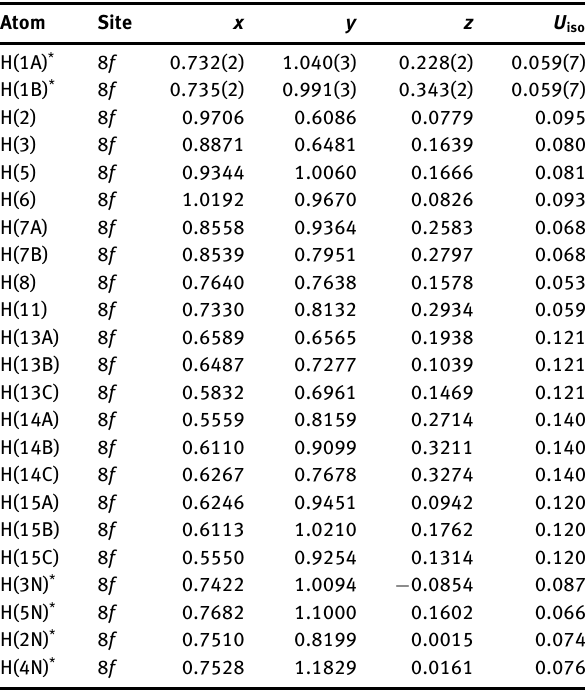
* Disordered, occupancy factor: 0.5.